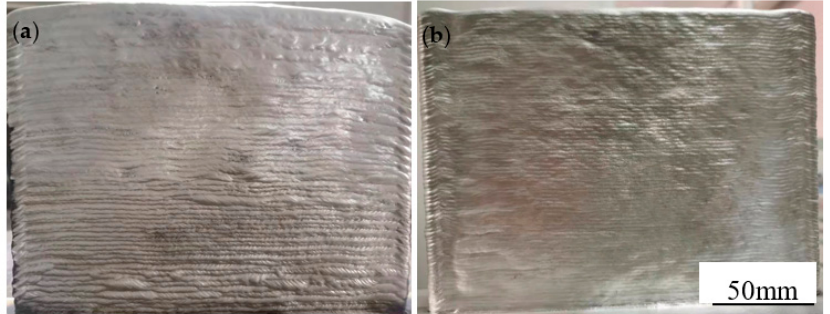
Figure 2. Surface morphology of single-wire and double-wire walls: ( a ) single-wire wall; ( b ) double-wire wall.